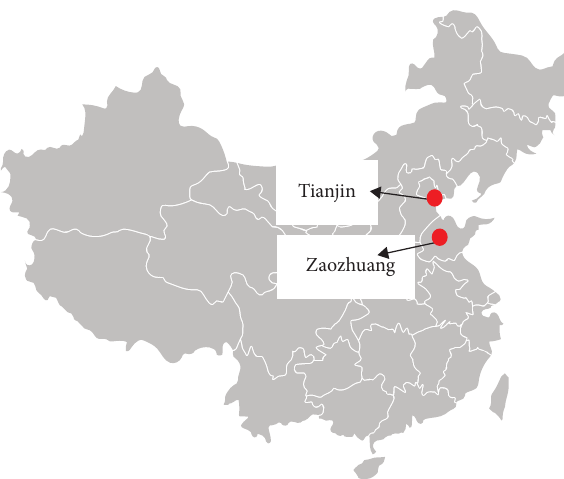
Figure 14: The geographical layout of